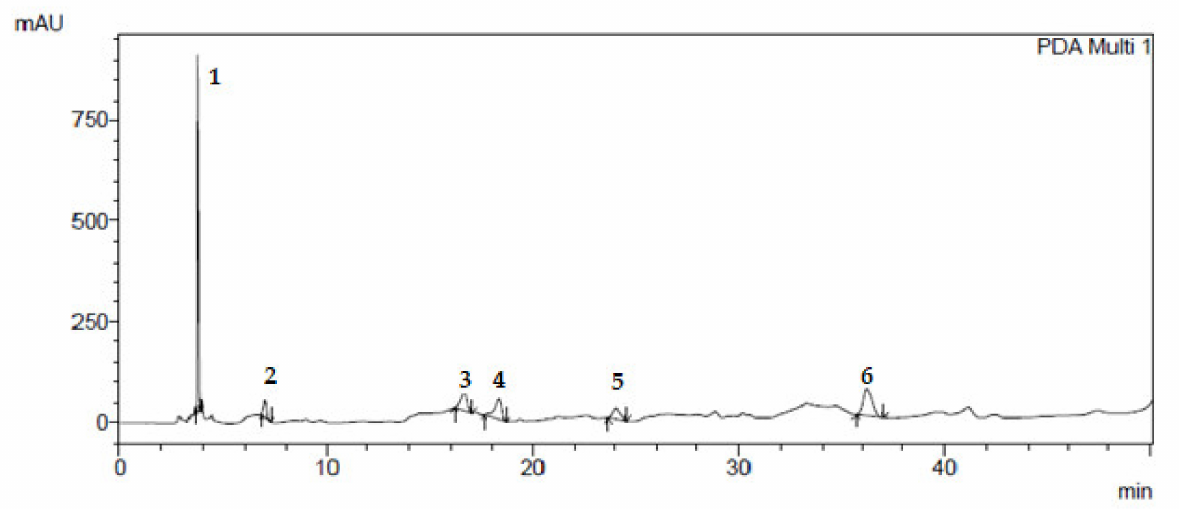
Figure 3. Isolation of hydroxyflavones from Dactylorhiza maculata extract samples by preparative chromatography: (1) api- genin; (2) 7,8-dihydroxyflavone; (3) 3-hydroxyflavone; (4) 5-hydroxyflavone; (5) luteolin; (6) luteolin 3,4 (cid:48) -diglucoside.